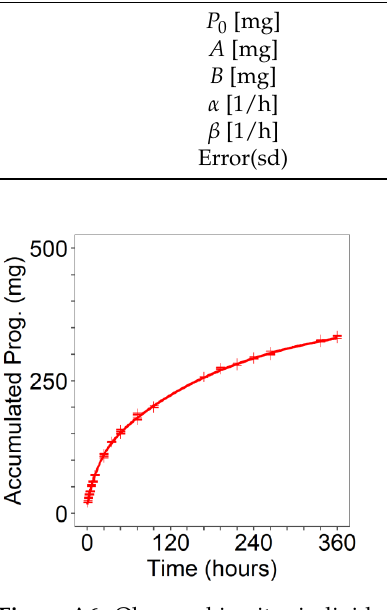
Table A4. Parameter estimates of the in vitro release model for test batch (batch E) at 375 mg.